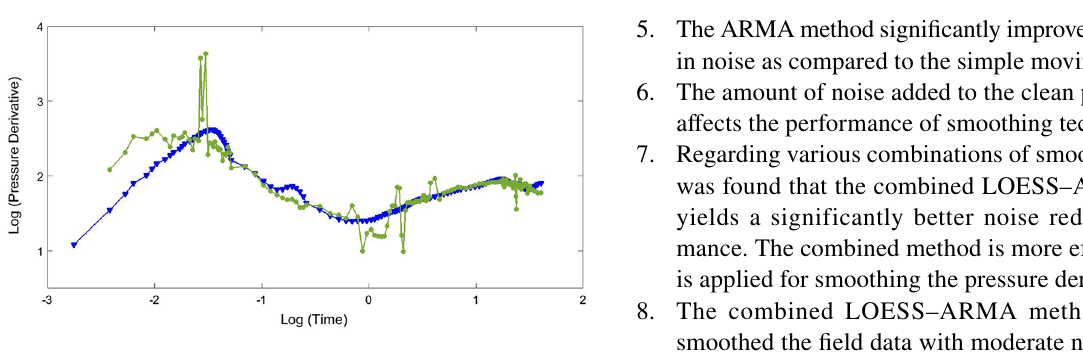
Fig. 15 (Green) the pressure transient test data published by Bourdet et al. (1984); (blue) the smoothed pressure derivatives using the com- bined LOESS–ARMA